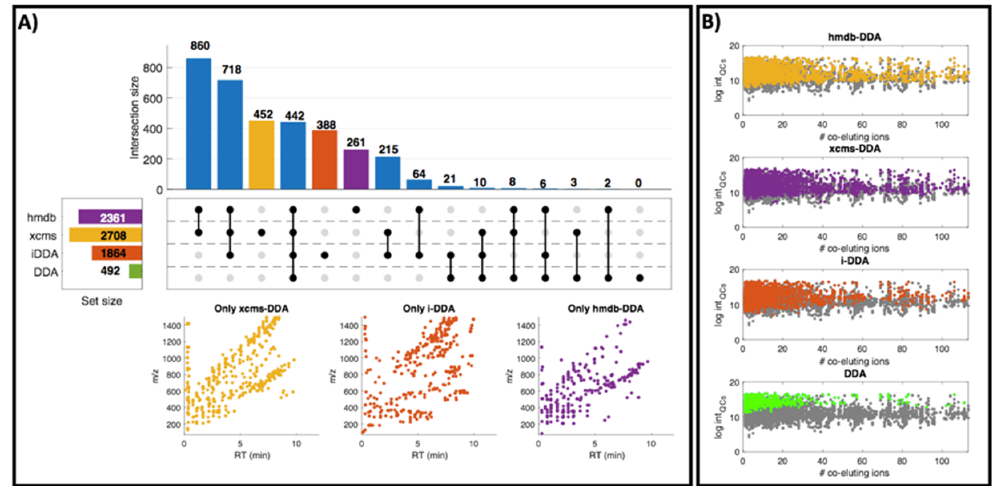
Figure 3. ( A-Top ) UpSet plot to visualize the intersecting sets of features selected as precursor for MS 2 spectra acquisition using DDA, i-DDA, xcms-DDA or hmdb-DDA. ( A-Bottom ) Distribution of the 452, 388 and 261 features exclusively selected as precursors by xcms-DDA, i-DDA and hmdb-DDA, respectively. ( B ) Distribution of the median intensity values in the sample batch of the fragmented features selected using DDA, i-DDA, xcms-DDA and hmdb-DDA (color dots) and of features that were not fragmented (grey dots).